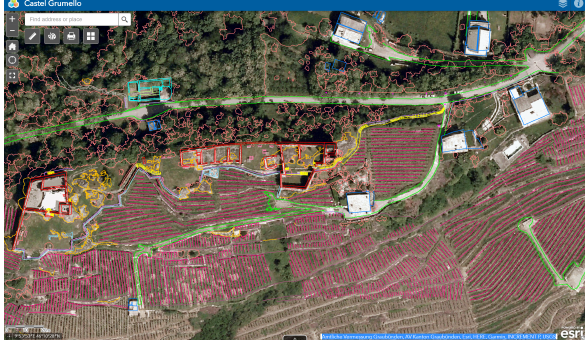
Figure 12: The 2012 orthoimage and some vector layers pro- duced in the project.